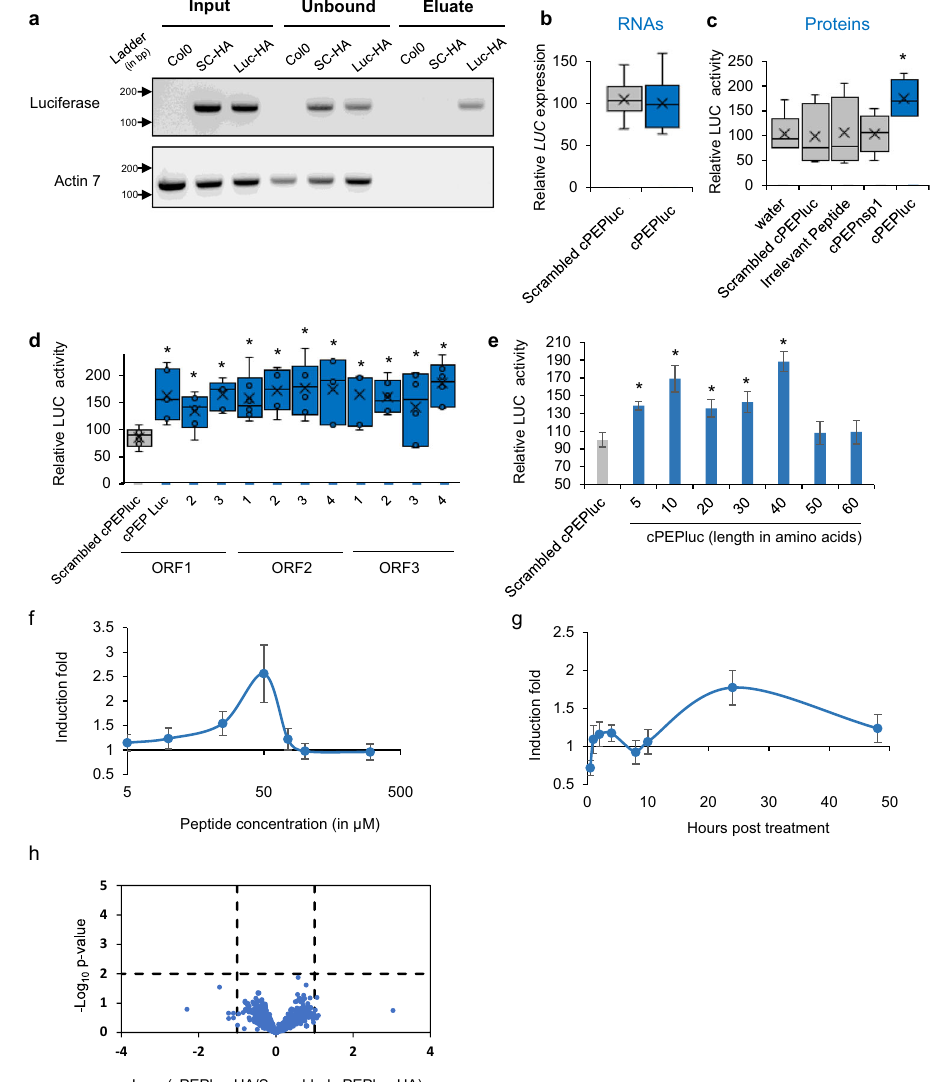
Fig. 1 | Complementary peptides increase protein expression. Analysis of luci- ferase expression in A. thaliana plants constitutively expressing LUC transgene. a Agarose gel after PCR ampli fi cation of RNA immunoprecipitation using anti-HA magnetic beads followed by RT-PCR, on plants treated with the indicated peptide (SC-HA: Scrambled cPEPluc-HA; Luc-HA: cPEPluc-HA). b Relative expression of luciferase transgene in plants treated with the indicated peptide, quanti fi ed byRT- qPCR. c – e Relative LUC quanti fi cationofplantstreatedwiththe indicatedpeptide. f , g Ratio of induction of LUC quanti fi cation of plants treated with cPEPluc com- pared to plants treated with a scrambled cPEPluc, using various concentrations of peptides( f )orharvestedatadifferenttimepoint( g ). h Proteomicanalysisofplants